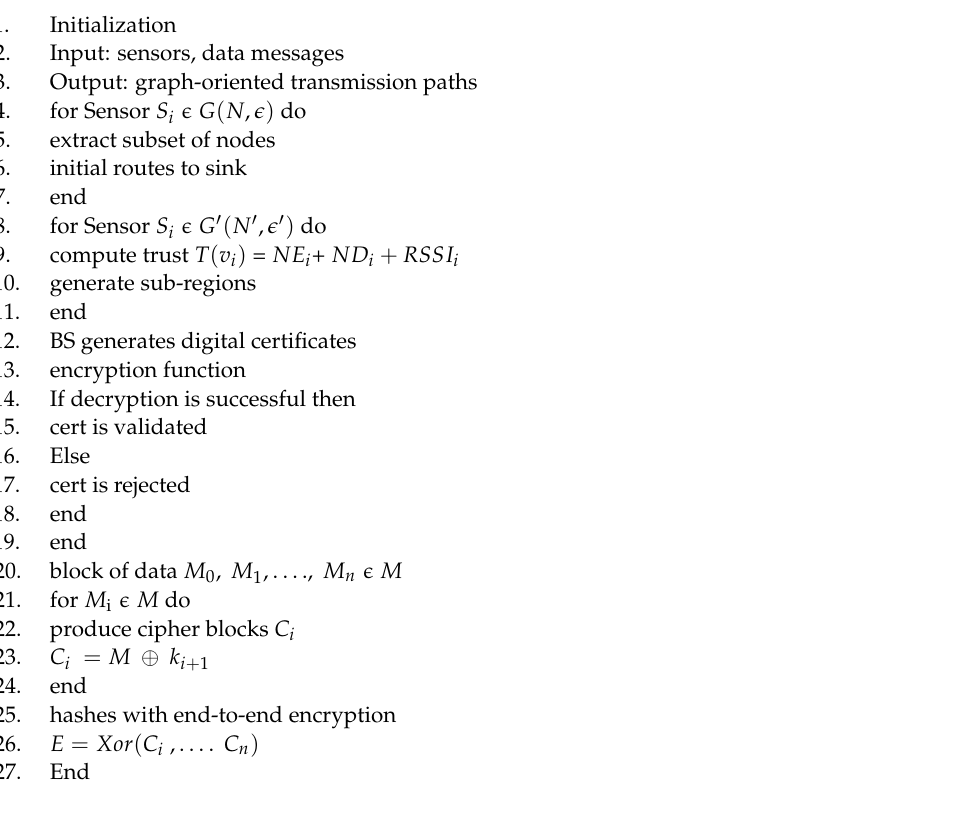
Algorithm 1: AI-enabled privacy-preserving big data